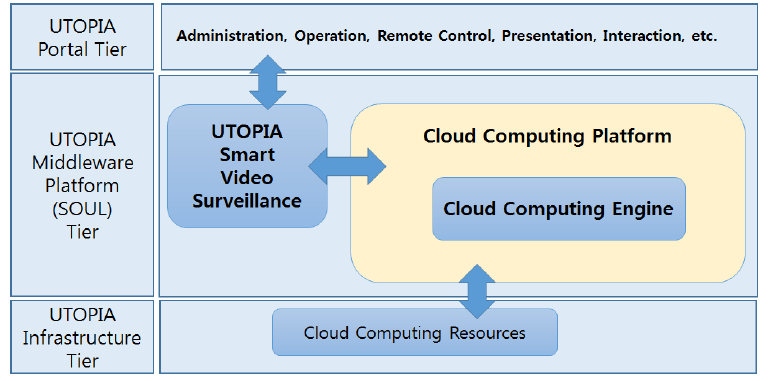
Figure 5. UTOPIA’s Cloud computing.